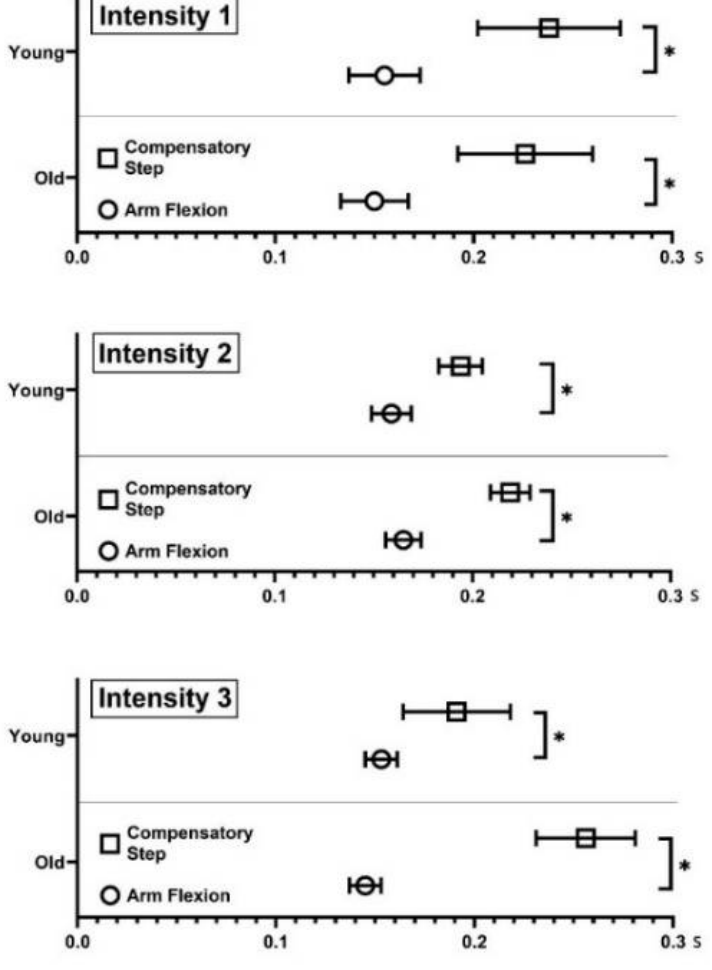
Figure 2. Onset latency of arm elevation and stepping response (first compensatory step lift-off) following a slip perturbation. Three different perturbation intensities (7.75 m/s 2 (intensity 1), 12.00 m/s 2 (intensity 2), and 16.75 m/s 2 (intensity 3) were tested with a displacement of 0.20 m. * represents difference between arm and stepping responses, p < 0.05. Error bars display standard error.